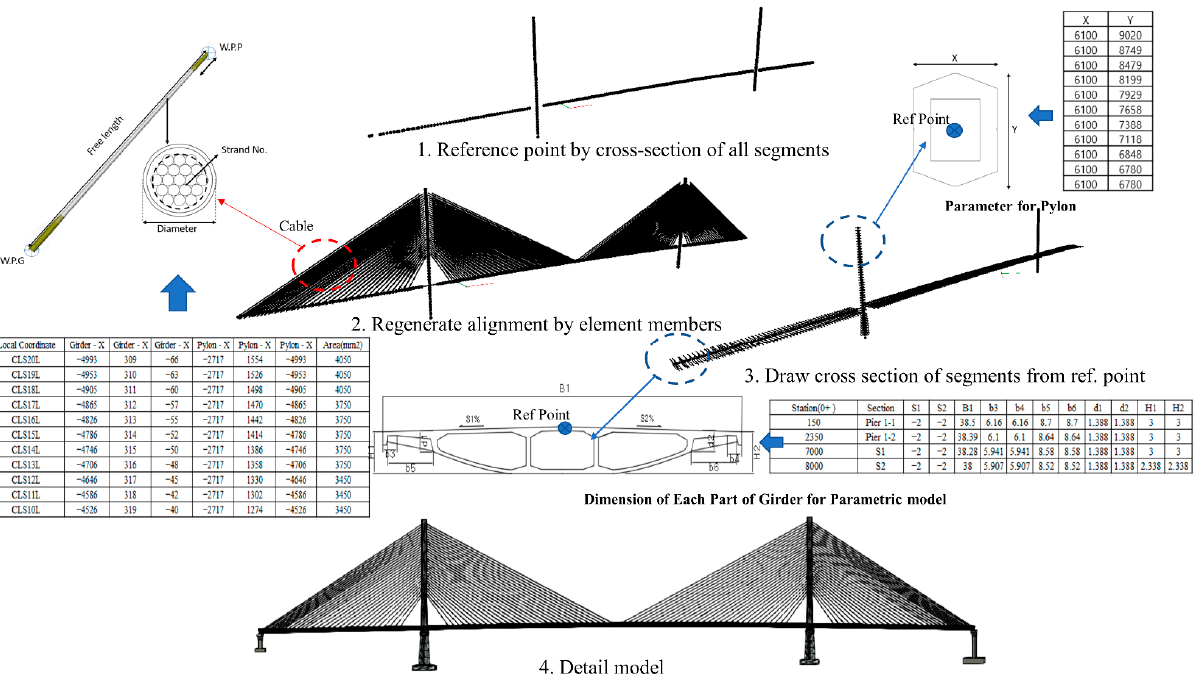
Figure 8. Algorithm and datasets for design development stage.